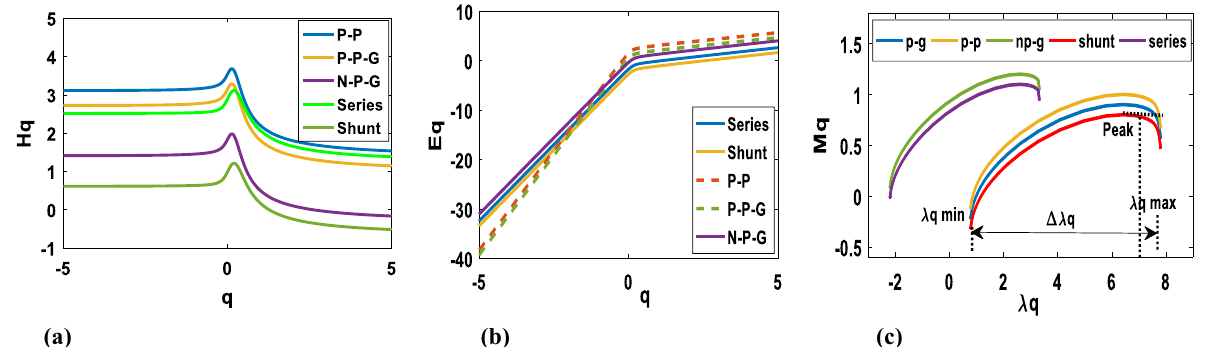
Fig. 17 Analysis of M-MFDFA features under fault resistance variation: a Hurst exponent, b Mass exponent and c Multifractal spectrum